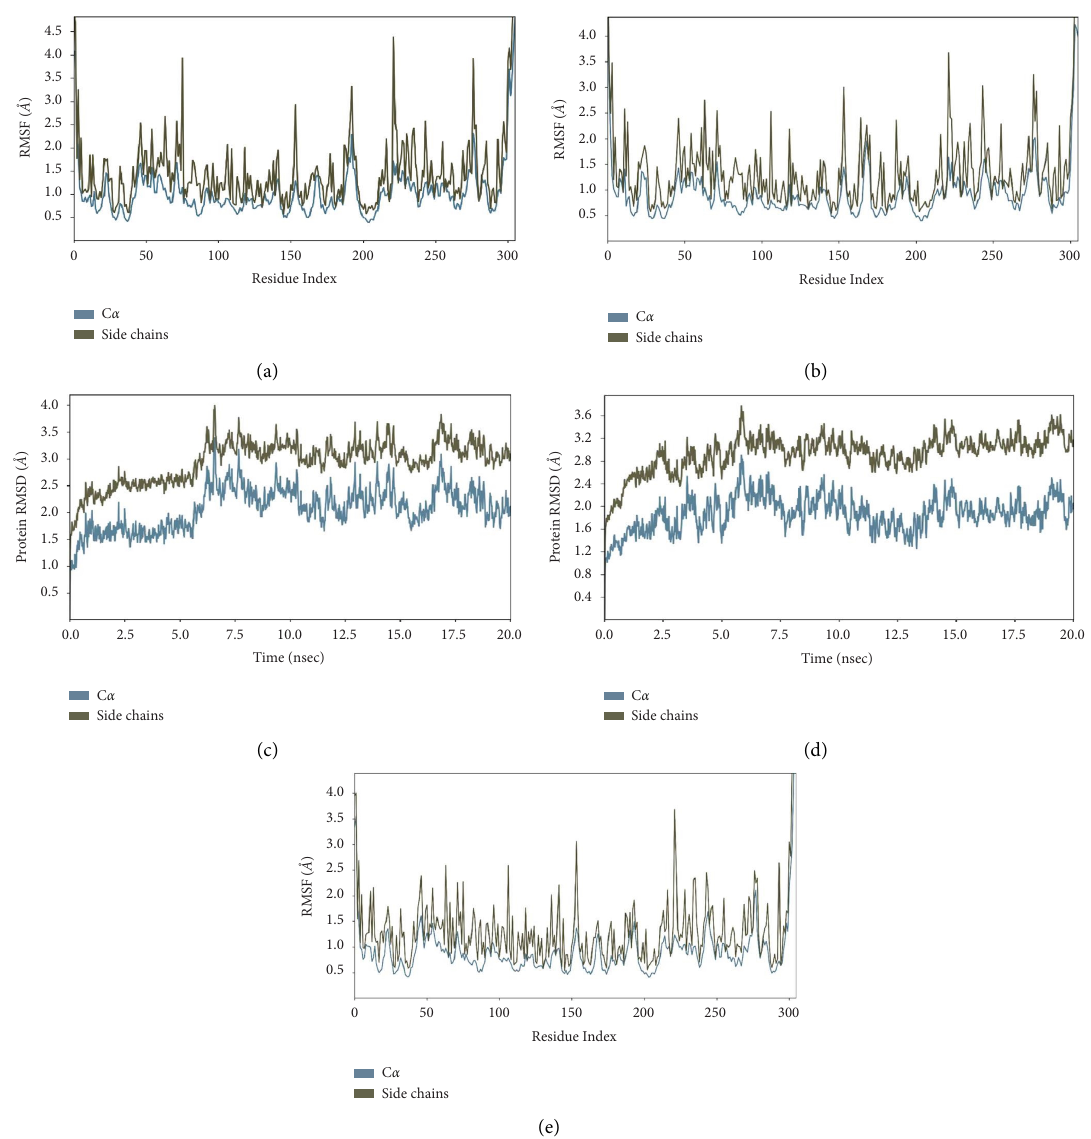
Figure 6: RMSF plots for each ligand: (a) quercetin; (b) procyanidin; (c) oleic acid; (d) methyl linoleic acid; (e)